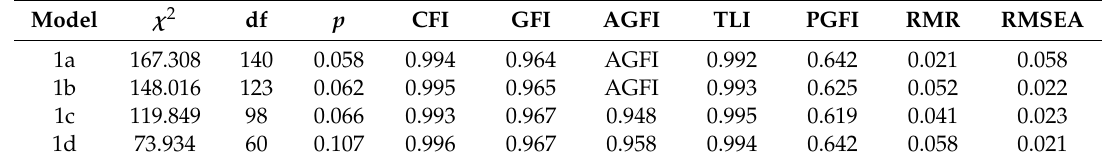
Table 2. Model fit indices.